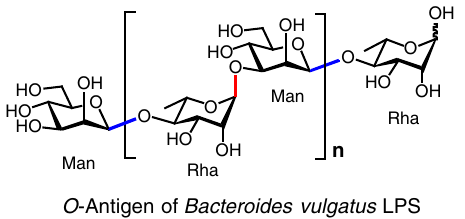
Fig. 1 The O-antigen glycans of Bacteroides vulgatus LPS. The α -(1 → 3) glycosidic bond between L -rhamnopyranose (Rha) and D -mannopyranose (Man) is highlighted in red, and the β -(1 → 4) glycosidic bond between Man and Rha in blue. Source data are provided as a Source Data fi